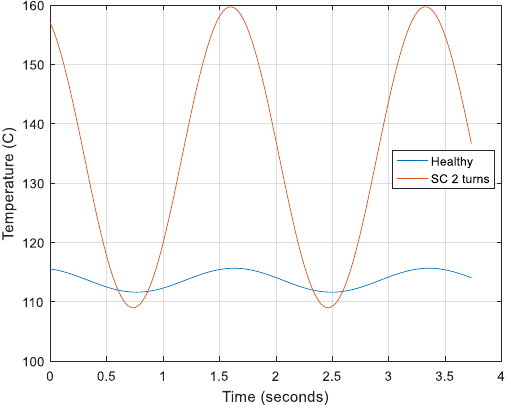
Figure 8. Sensor temperature for healthy machine and machine with turn-to-turn short circuit in one slot.